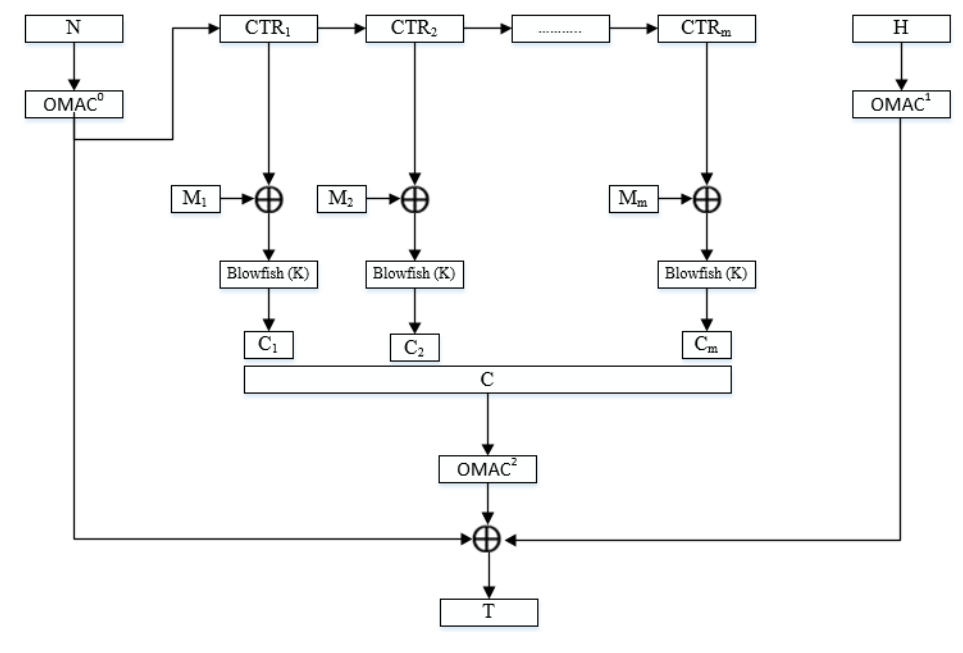
Figure 13. Blowfish + EAX part of SDA ‐ RDOS Protocol.